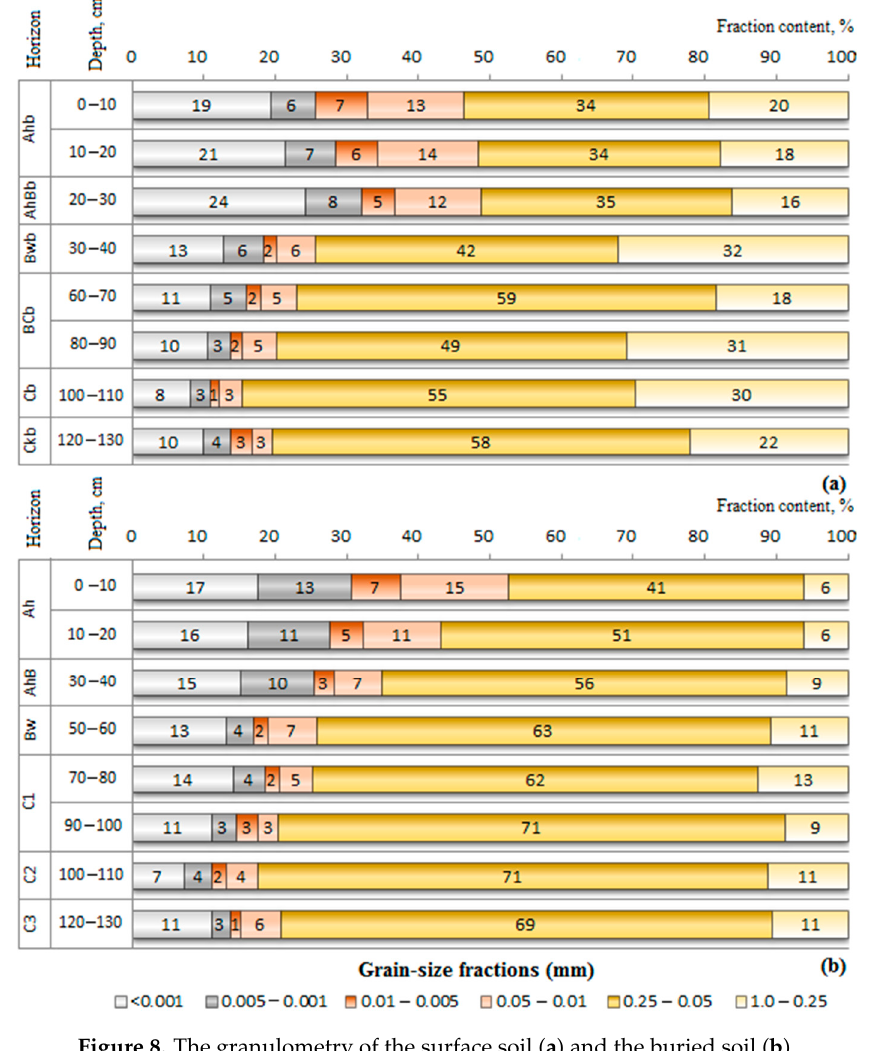
Figure 8. The granulometry of the surface soil ( a ) and the buried soil ( b ).